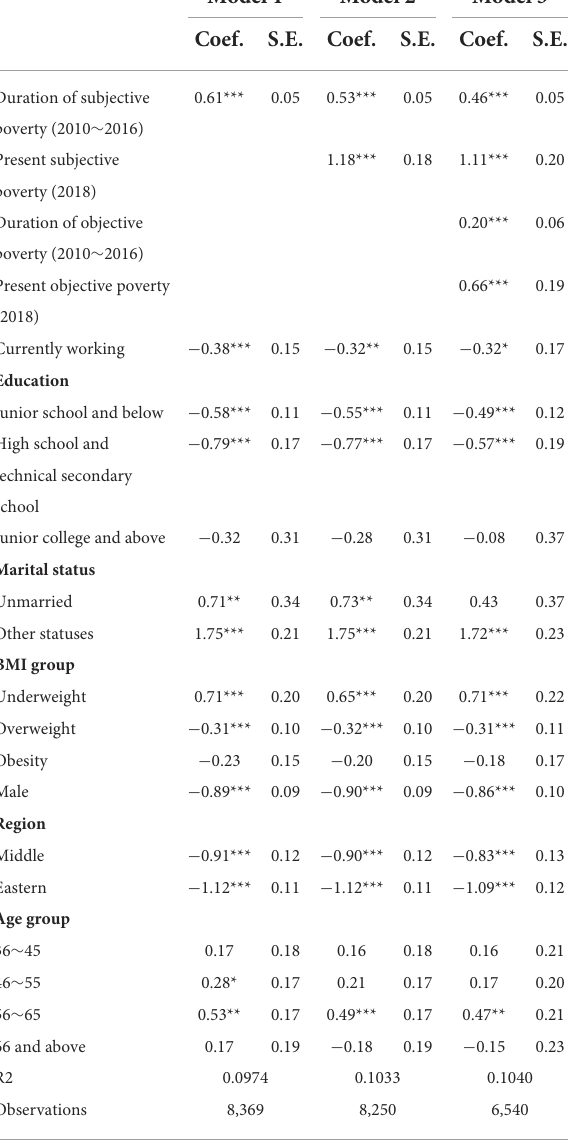
TABLE 9 Different durations of subjective poverty and depressive symptoms. Total sample Urban sample Rural